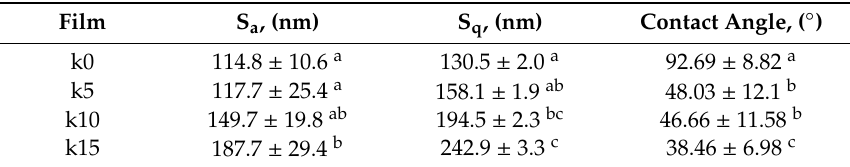
Figure 3. The surface texture of films with varying kaolin content as a height domain, measured using atomic force microscopy (AFM) ( a ) 2D; ( b ) 3D. Table 2. The values of the roughness and contact angle